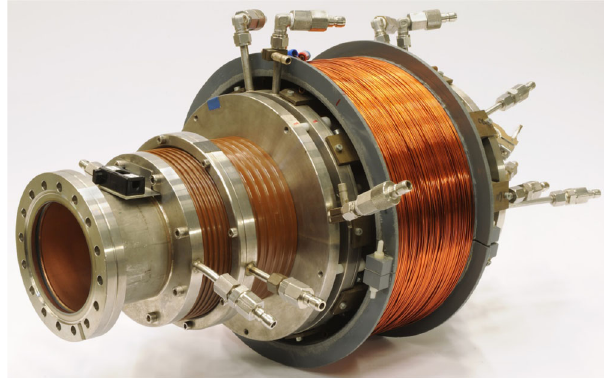
FIG. 4. The setup of the MUCIS ion source with external solenoid.